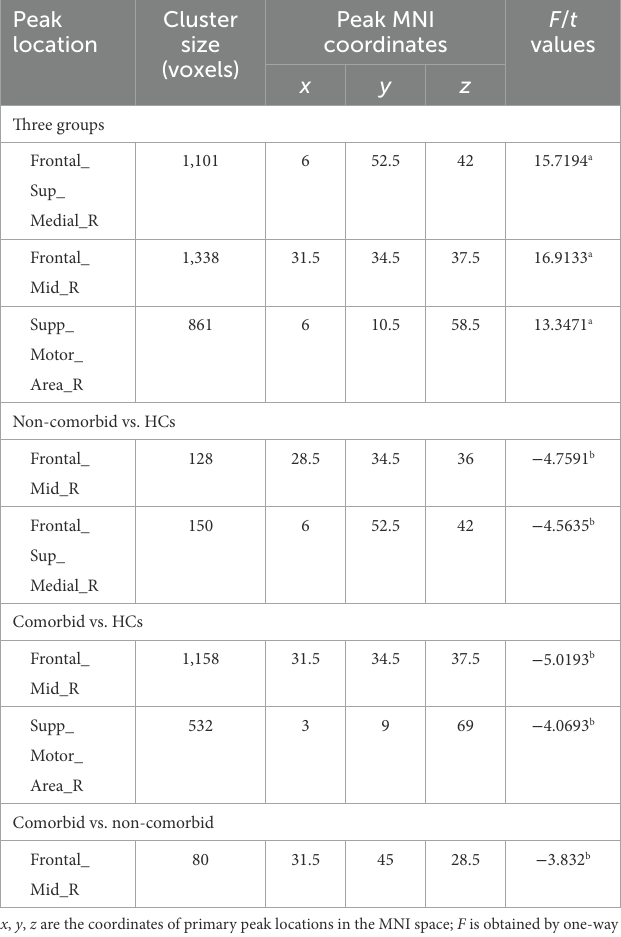
TABLE 2 Brain areas with significantly different GMV among the comorbid, non-comorbid, and HC groups.